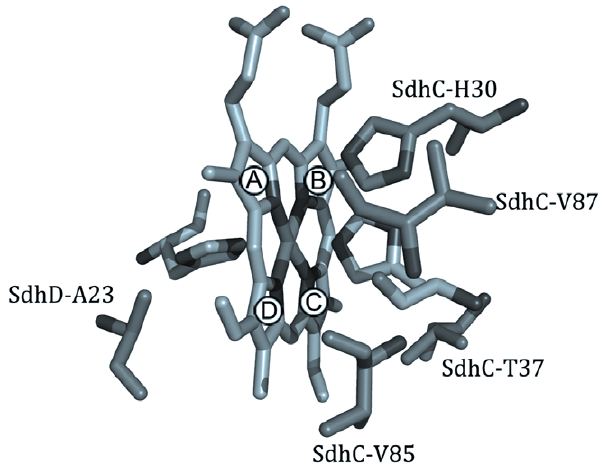
Figure 5. Interactions between the heme face and surrounding residues. Mutations to the residues depicted are able to affect the planarity of the porphyrin ring. Pyrrole rings are denoted as (A) top, distal (B) top, proximal (C) bottom, proximal (D) bottom, distal. (pdb: 2WDV [31]).